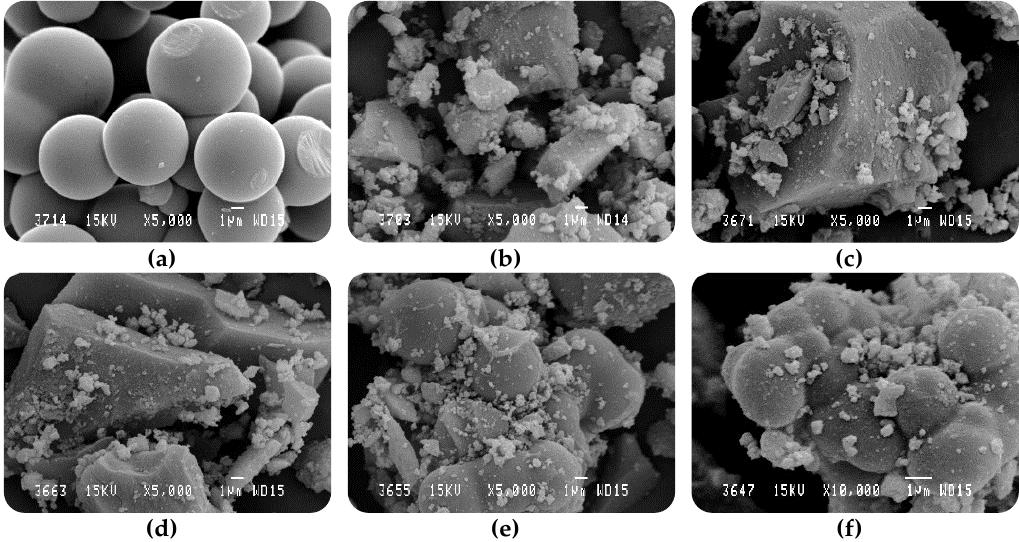
Figure 3. SEM images of: ( a ) AC, ( b ) TiO 2 (nt), ( c ) TiO 2 -AC0.5 (nt), ( d ) TiO 2 -AC1 (nt), ( e ) TiO 2 -AC5 (nt) and ( f ) TiO 2 -AC10 (nt).